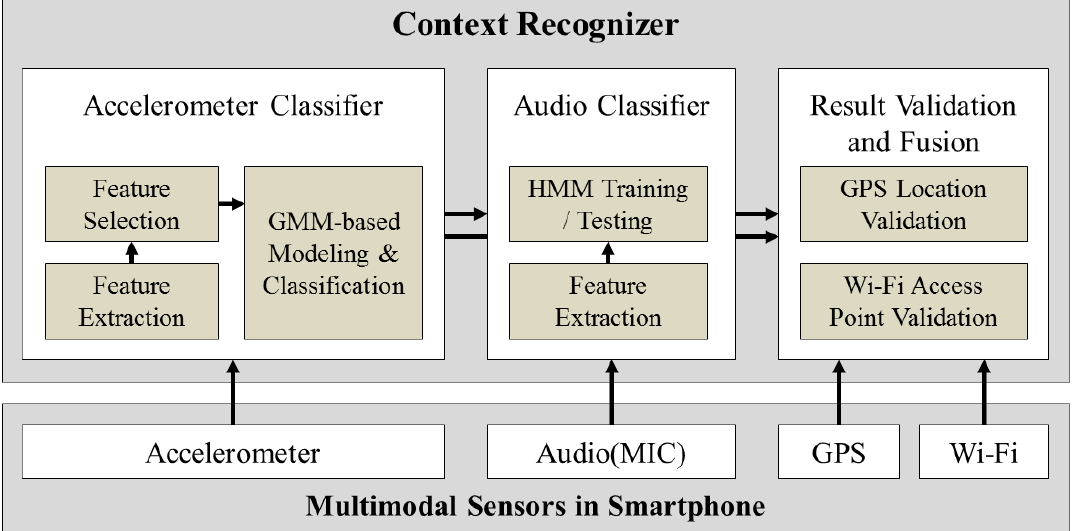
Figure 1. Overall architecture of the proposed system—Context